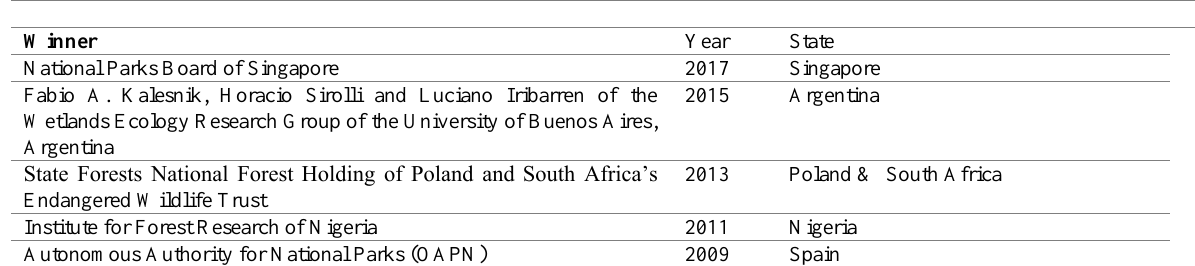
Table 5: The UNESCO Sultan Qaboos Prize for environmental preservation winners